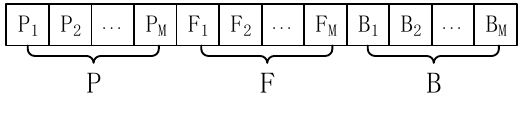
Figure 2. Encoding Figure 2. Encoding method.